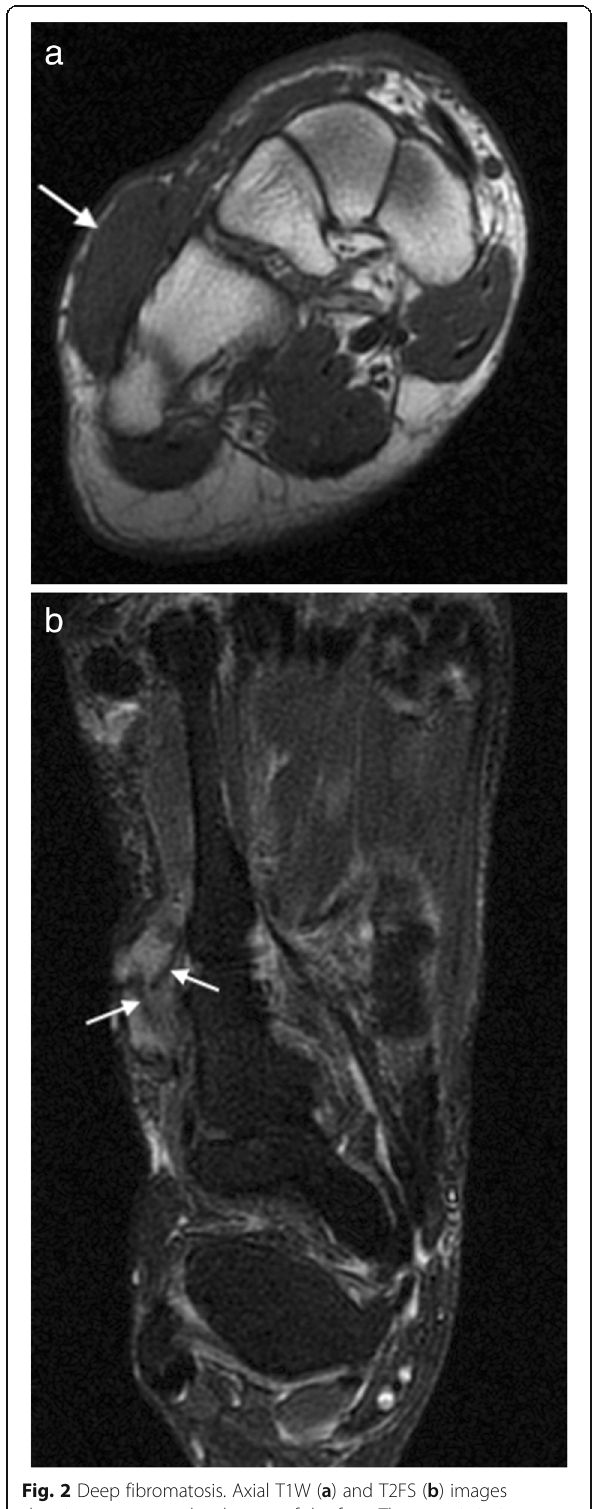
Fig. 2 Deep fibromatosis. Axial T1W ( a ) and T2FS ( b ) images showing a mass on the dorsum of the foot. The mass is isointense to muscle on T1W. On T2FS, the mass is hyperintense with linear low signal collagen bands